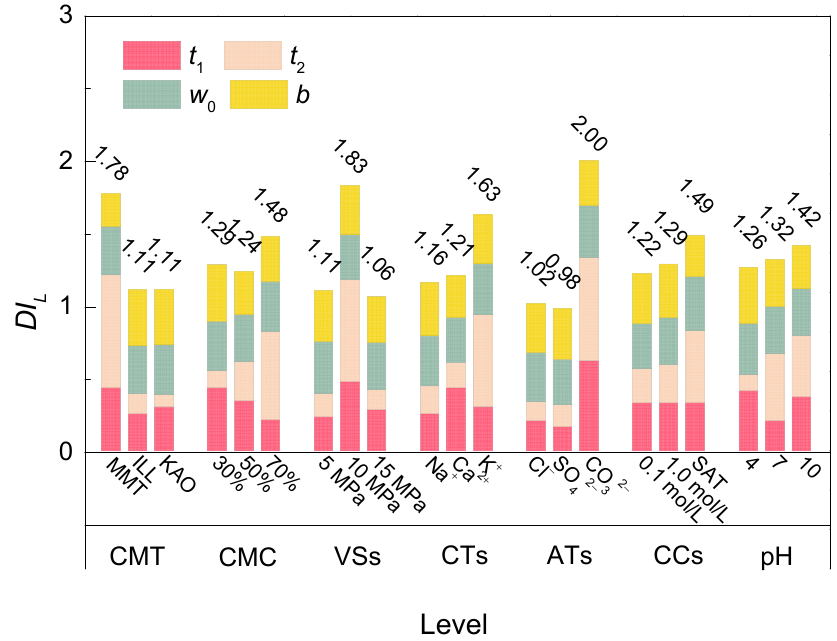
Figure 8. Influence of different levels on the water absorption process of rocks. The numbers above the columns are the sum of the normalized calculation results of the four response indicators.